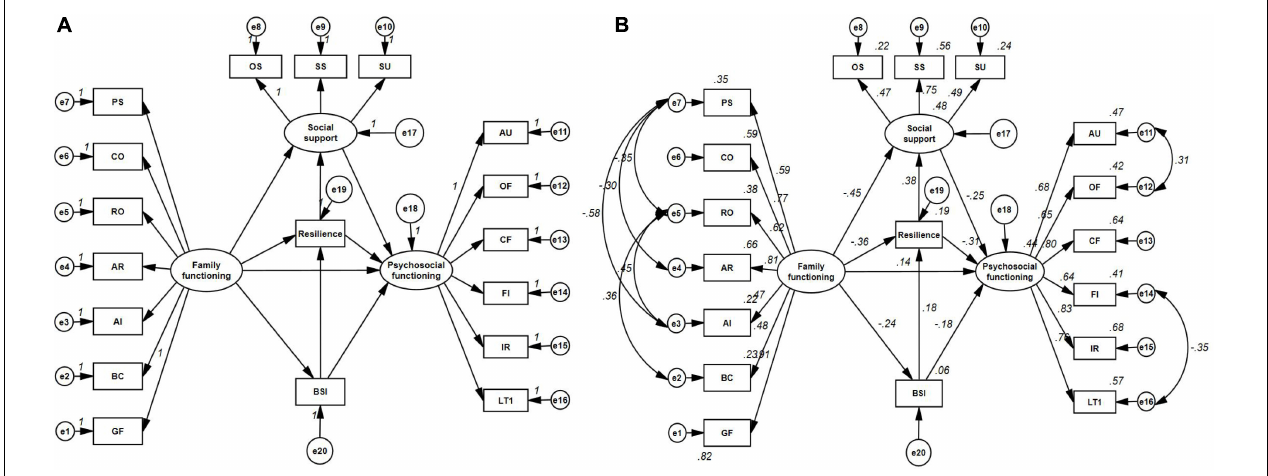
FIGURE 1 | The original model (A) and final model (B) . PS, Problem Solving; CO, Communication; RO, Roles; AR, Affective Responsiveness; AI, Affective Involvement; BC, Behavior Control; GF, General Functioning; OS, Objective Support; SS, Subjective Support; SU, Support Utilization; AU, Autonomy; OF, Occupational Functioning; CF, Cognitive Functioning; FI, Financial Issue; IR, Interpersonal Relationships; LT, Leisure Time; BSI, Beck Scale for Suicide